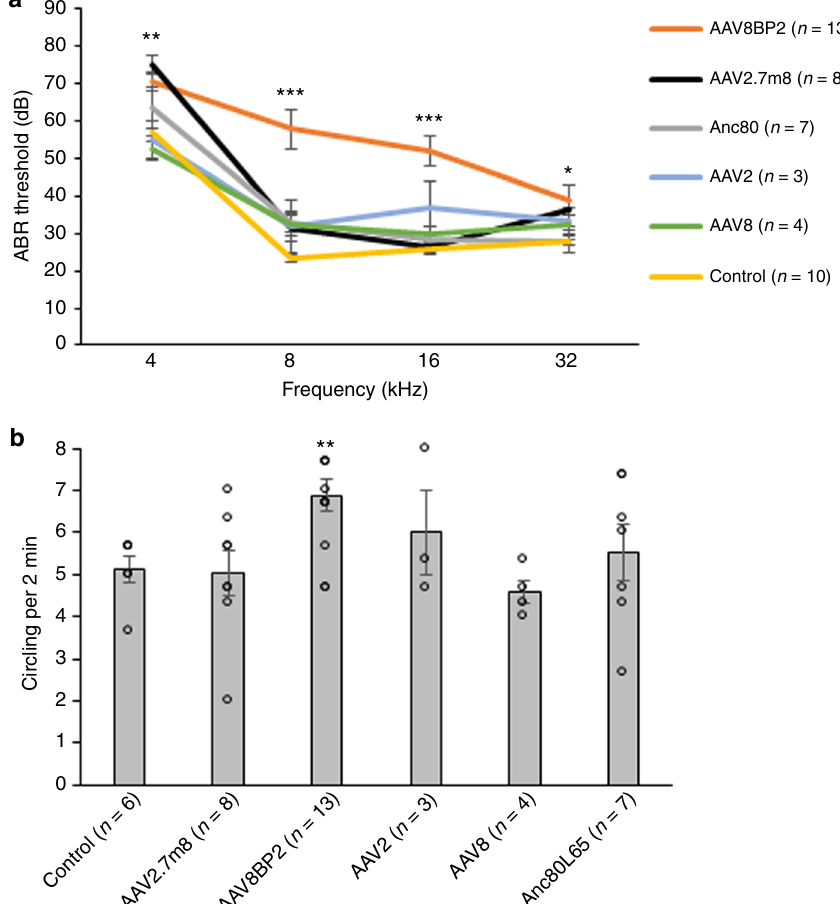
Fig. 5 AAV2.7m8 has a minimal adverse effect on auditory and vestibular functions in injected mice. a Auditory brainstem responses (ABRs) were recorded to assess the auditory function of mice that underwent synthetic AAV injection via the posterior semicircular canal approach. AAV2.7m8, AAV2, AAV8, and Anc80L65 had minimal adverse effects on the auditory function, while the injection of AAV8BP2 caused a 10 – 25 dB ABR threshold elevation compared to non-injected control mice. b Circling behavior was assessed in mice that underwent AAV injection via the posterior semicircular canal approach. AAV2.7m8, AAV2, AAV8, and Anc80L65 did not cause statistically signi fi cant increase in circling behavior compared to non-injected control mice, while the injection of AAV8BP2 caused a slight elevation in circling behavior compared to non-injected control mice. Statistical signi fi cance with reference to non-injected normal control mice is shown above error bars (* represents p < 0.05, ** represents p < 0.01, and *** represents p < 0.001; ANOVA). Error bars represent standard errors. Open circles represent the average value of each animal. n represents the number of animals tested. Source data are provided as a Source Data fi le.